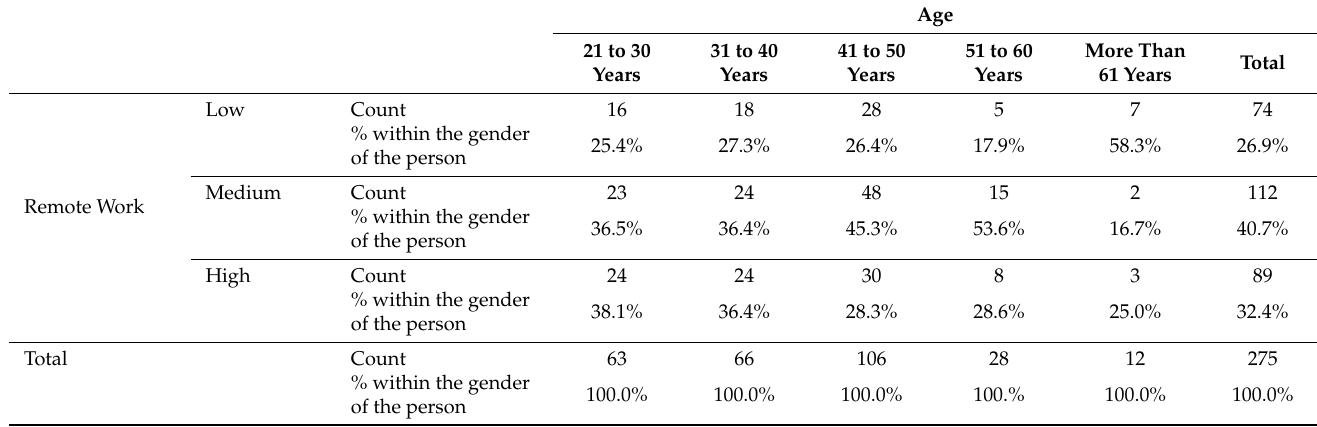
Table 11. Cross table of remote work level and age.